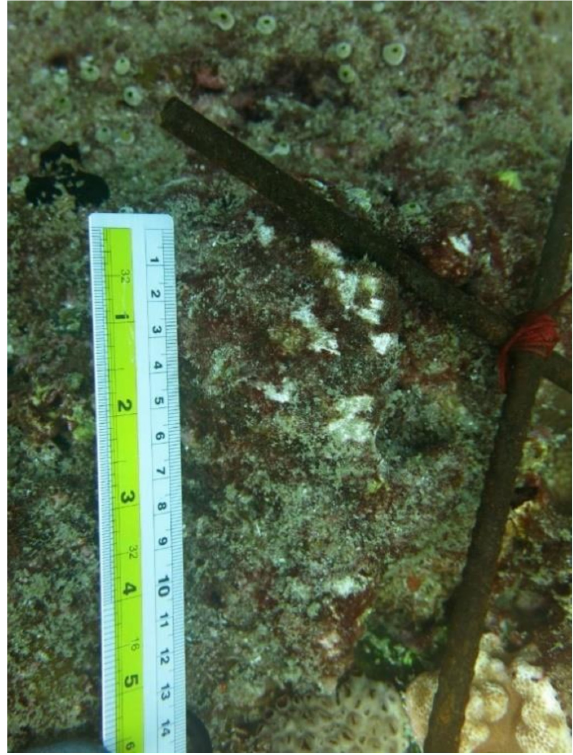
Figure A7. Bite marks of S. rubroviolaceus on reef